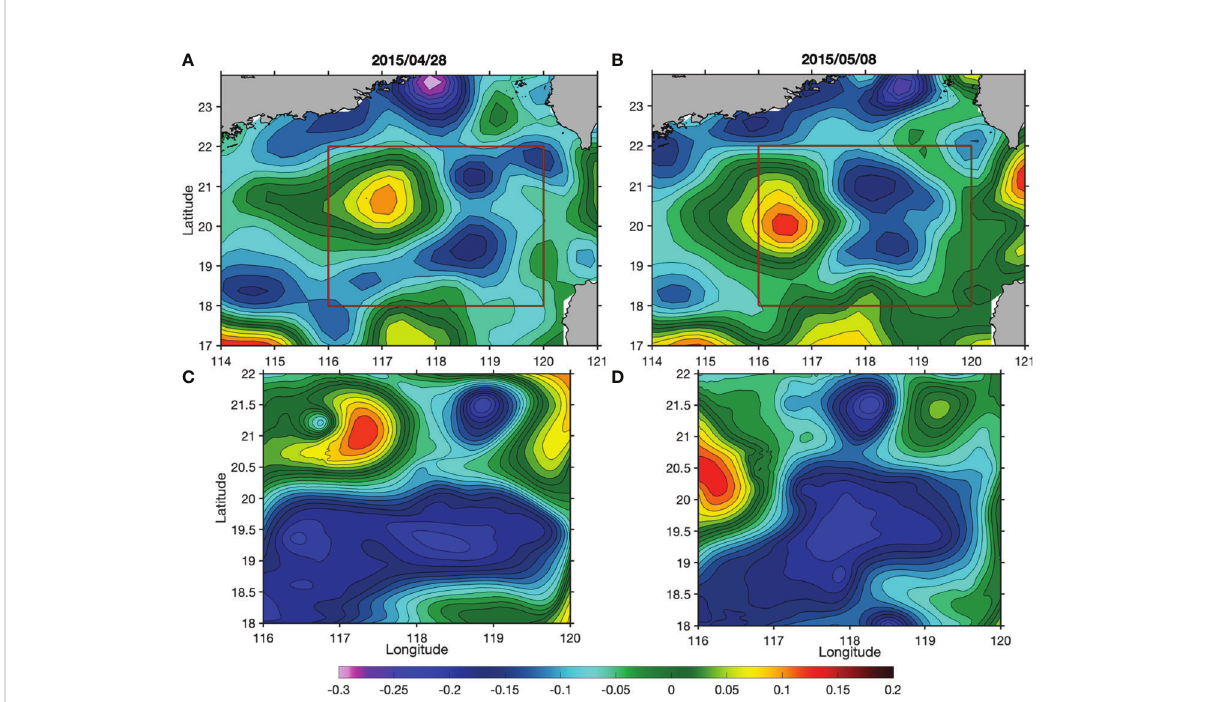
FIGURE 4 Comparisons of spatial distributions of SLA (units: m) from altimeter data (A, B) and the model outputs (C, D) on 28 April and 8 May. The red rectangles in (A, B) depict the domain of the model.